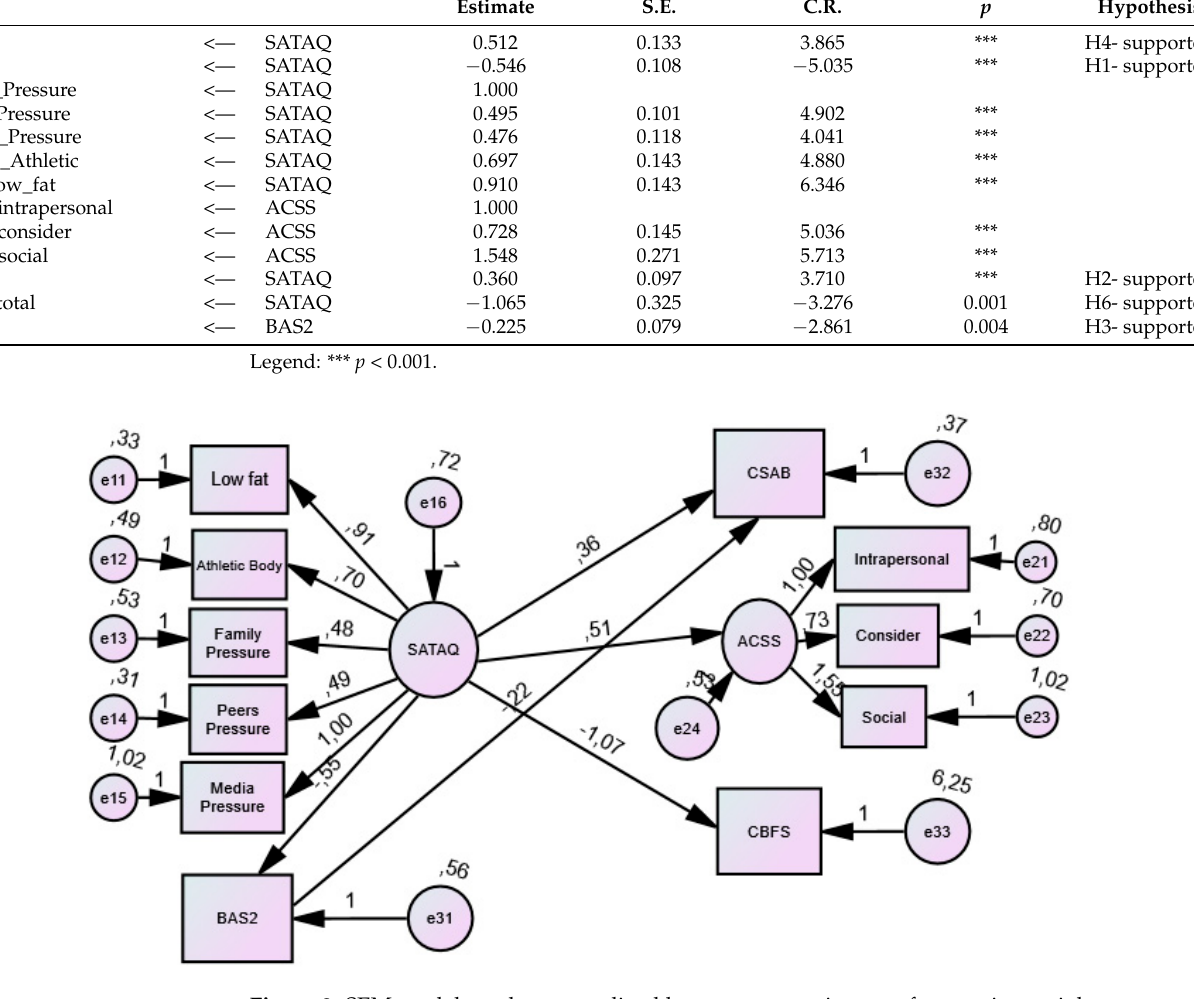
Figure 2. SEM model results: generalized least squares estimates of regression weights.